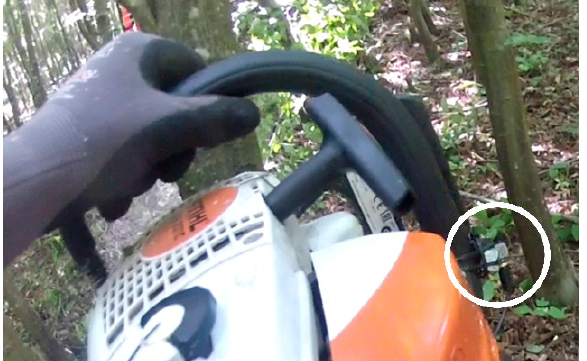
Figure 7. Distance of the accelerometer to the operator’s hand on the front handle when the chainsaw is tilted.